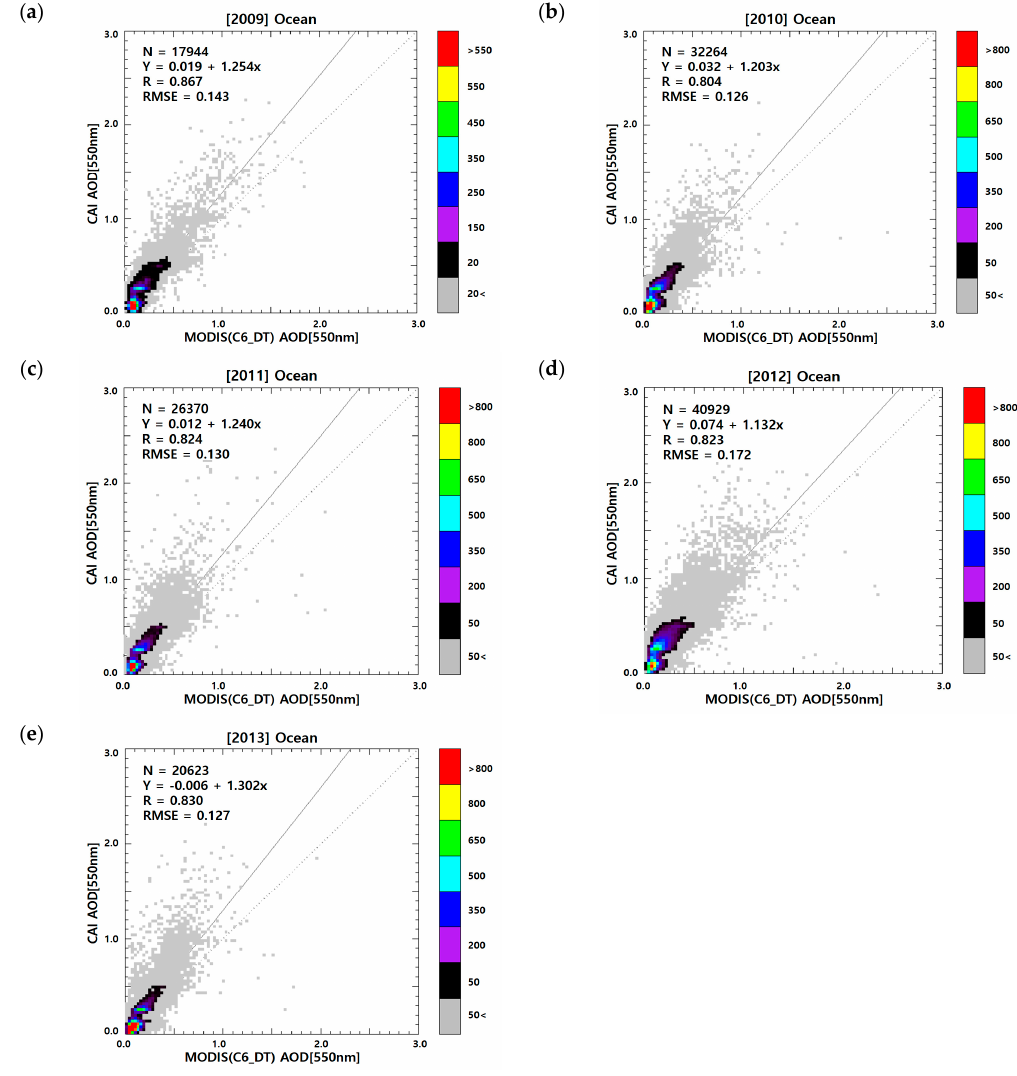
Figure 7. Comparisons of AOD retrieved from the TANSO-CAI aerosol algorithm with those from Aqua/MODIS (collection 6) dark target algorithm over ocean ( a ) from June to December 2009; the whole of ( b ) 2010; ( c ) 2011; ( d ) 2012; and ( e ) 2013. The colored pixels represent a frequency number with a bin size of 0.03 AOD. The black solid and dashed lines are the linear regression and the one-to-one lines, respectively.